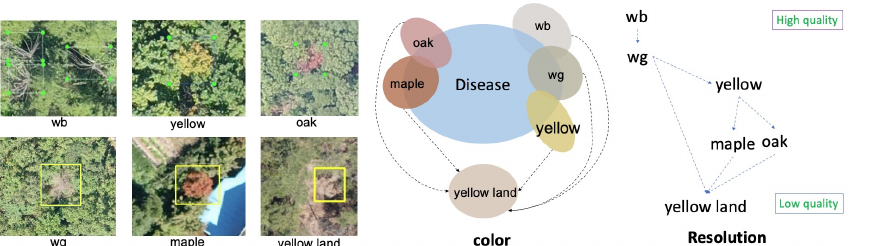
Figure 2. Left figure : the object of hard negative samples. Middle figure : the appearance relationship among “disease-like” objects and ground truth disease. Right figure : the reasons that the network predicted the different types of false negative samples. In high-quality image, branches and leaves are clear and easily identifiable. However, in low-resolution image, the real PWD-infected trees appear similar to the maple tree and the yellow